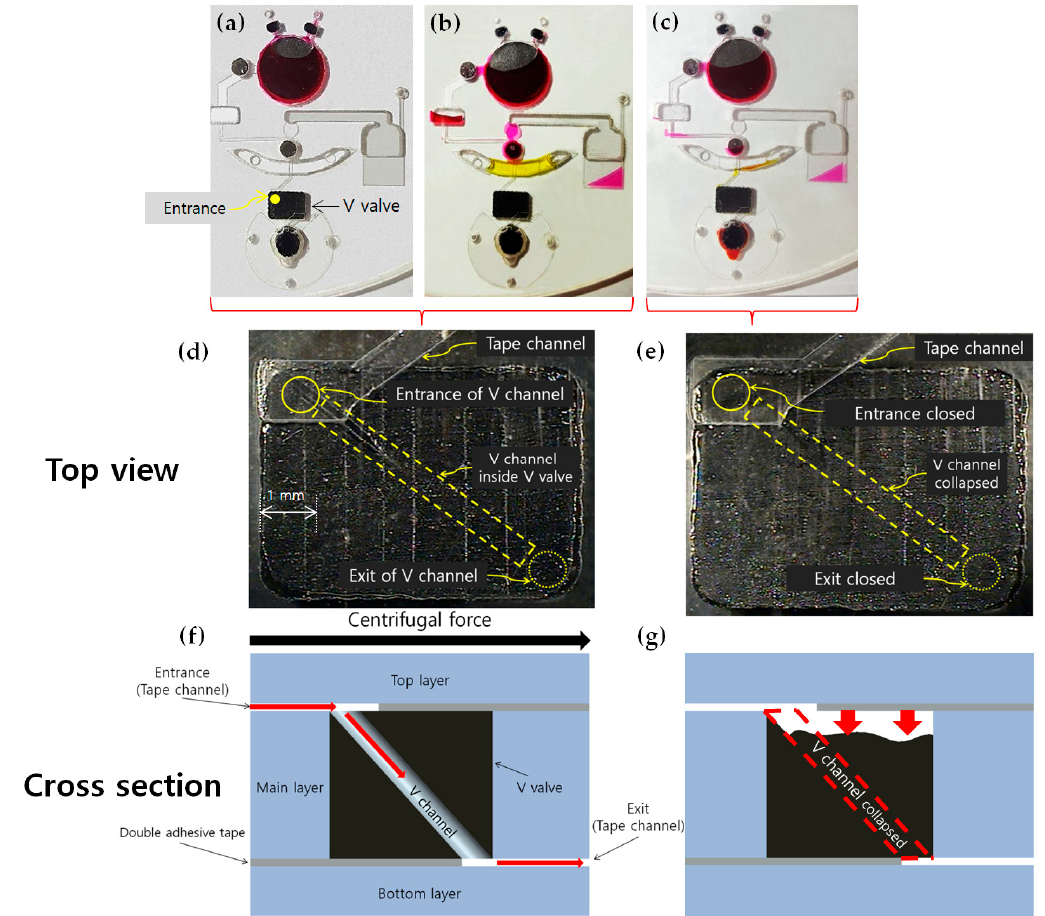
Figure 3. The schematic illustration of the flow of fluids in the PCR–LOD during the PCR amplification process: ( a ) The cultured Salmonella (dissolved in Simplex reagent (red)) was loaded, V valve no. 1 was closed, and the PCR–LOD was spun to purify the heated cell lysis reagents; ( b ) the thin-film valve no. 1 was opened and the PCR–LOD was spun so that the supernatant with purified DNA could fill the metering chamber. The PCR premix (yellow) was loaded in the PCR reagent reservoir and the thin-film valve no. 2 was then opened; ( c ) the PCR–LOD was spun so that the mixed reagents (purified DNA and PCR premix) flowed into the amplification chamber, then the V valve no. 2 was closed. Enlarged top view of the V valve; ( d ) reagents can flow from the entrance to the exit through the V channel; ( e ) the V valve closed by the laser module; ( f ) cross-sectional illustration corresponding to ( d ); ( g )